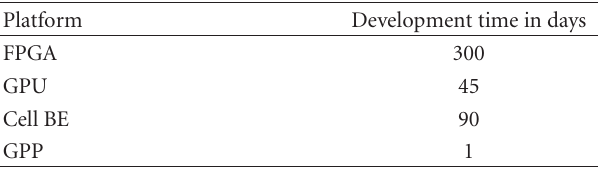
Table 7: Performance per $ spent for each